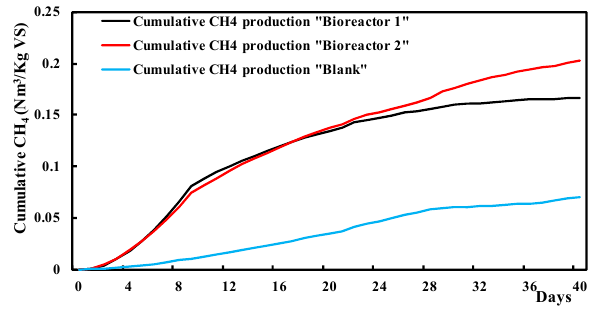
Figure 5. Cumulative bio-methane production of the bioreactors.